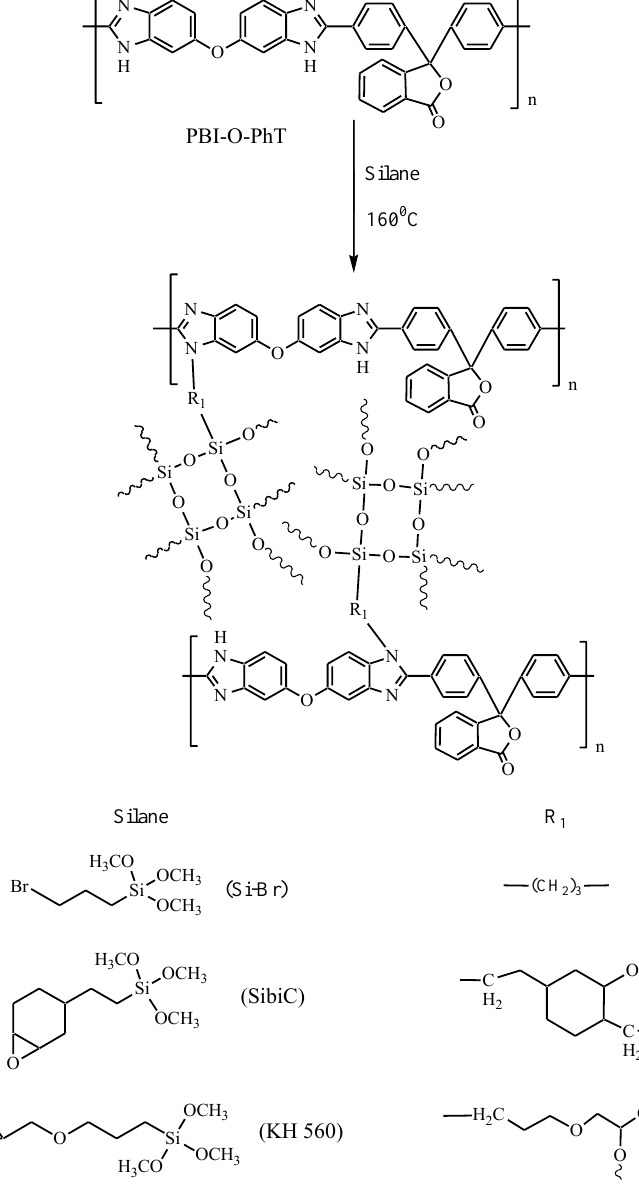
Figure 1. Scheme of the crosslinking reaction of polybenzimidazole with silanes of different struc- tures.